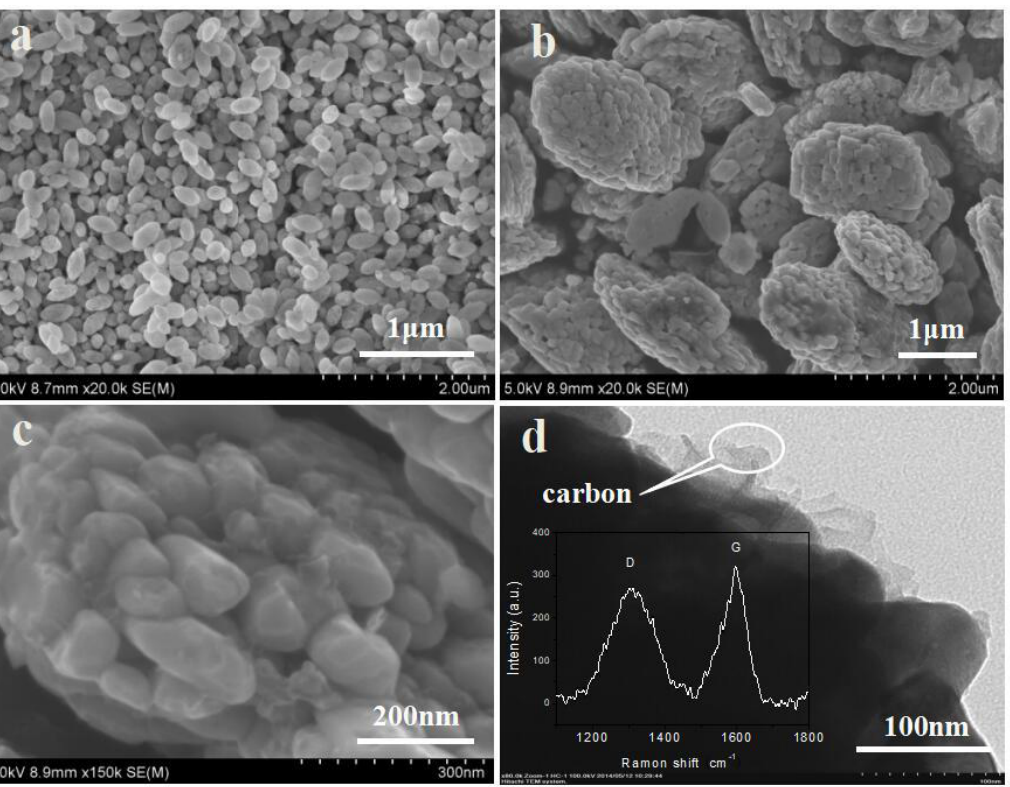
Figure 2. SEM images of LiFePO 4 prepared without OA ( a ) and with OA ( b ), high magnification ( c ), TEM with an inset of Raman result LiFePO 4 microspheres prepared with OA ( d